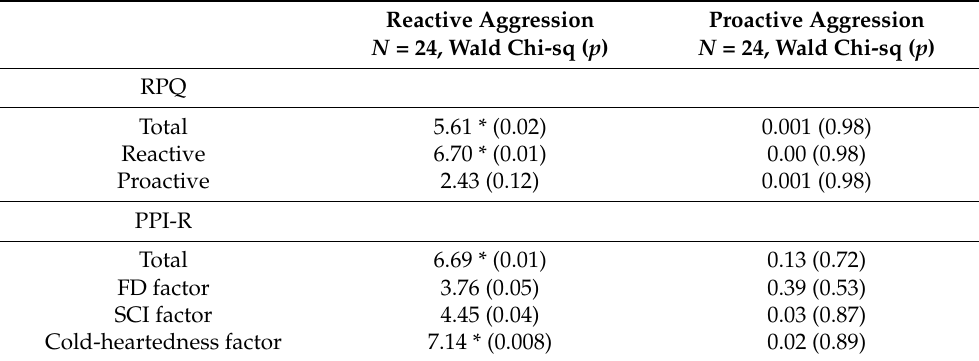
Table 2. Study 1: Negative binomial regression analysis outcomes on the relationship between study variables and continuous degree of reactive/proactive aggression displayed in VR.